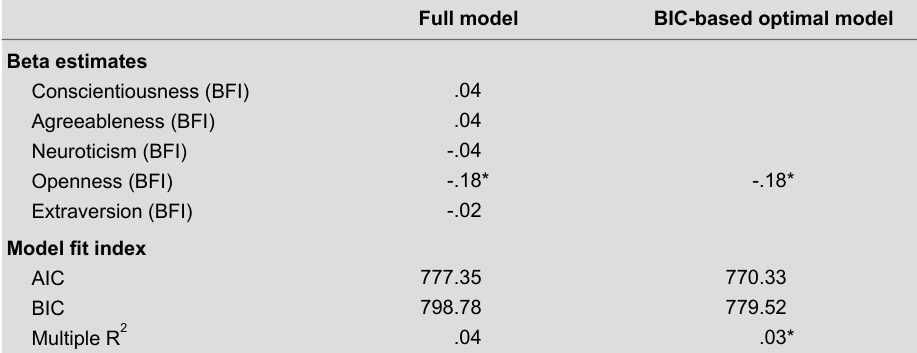
Regression Results for Predicting Centrality of Visual Aesthetic Products - Response, Using glmulti to Exhaustively Fit All Possible Models